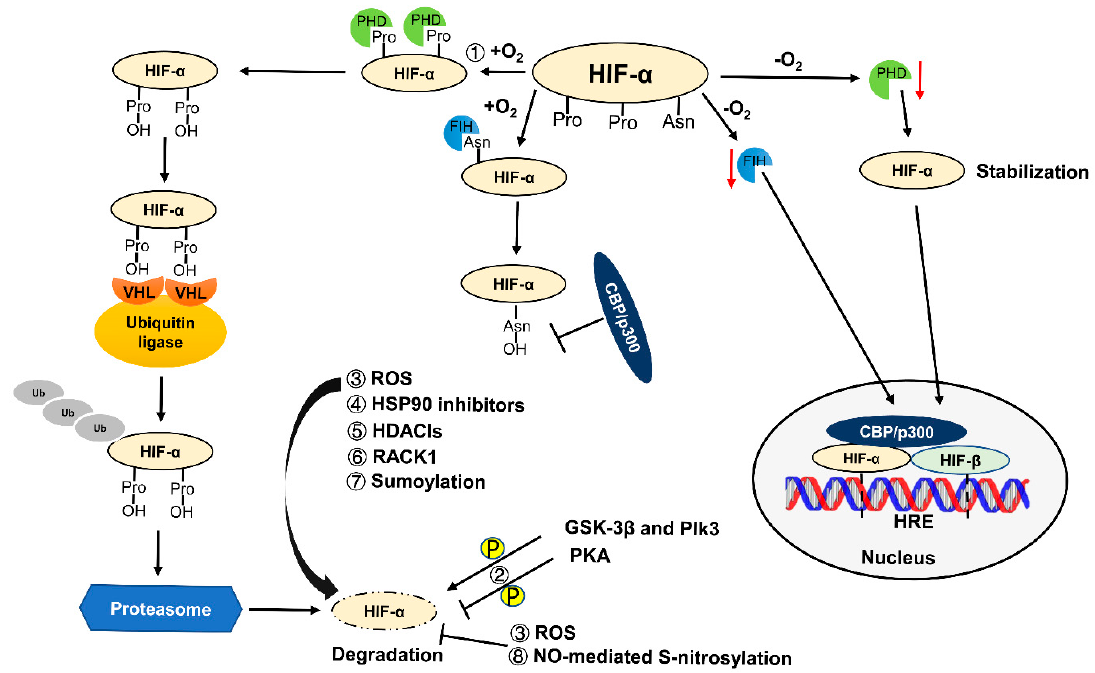
Figure 1. Regulation of the stability and transcription activity of HIF. In the presence of oxygen or normoxia, PHDs hydroxylate two prolyl residues of HIF- α . The hydroxylated HIF- α then binds to VHL-E3-ubiquitin ligase complex, leading to poly-ubiquitination and proteosomal degradation. Meanwhile, FIH hydroxylates an asparaginyl residue of HIF- α . Asparaginyl hydroxylated HIF- α prevents the recruitment of CBP/p300 coactivators, which is required for the full transcriptional activity of HIF. In the absence of O 2 or hypoxia, PHD-mediated prolyl residue hydroxylation is inhibited, resulting in HIF- α stabilization. The stabilized HIF- α translocates into nucleus and then dimerizes with HIF- β to transactivate target genes. Meanwhile, FIH-mediated asparaginyl residue hydroxylation is also inhibited, causing the recruitment of CBP/p300 coactivators to enhance the transcription activity of HIF. In addition to oxygen, phosphorylation and ROS may play dual roles in HIF- α regulation; HSP90 inhibitors, HDACIs, RACK1, and sumoylation can decrease the stability of HIF- α , while NO-mediated S-nitrosylation can enhance the stability of HIF- α . Abbreviations: hypoxia-inducible factor (HIF), prolyl hydroxylase domain-containing protein (PHD), von Hippel–Lindau (VHL), factor inhibiting HIF (FIH), CREB-binding protein (CBP), hypoxia response element (HRE), reactive oxygen species (ROS), histone deacetylase inhibitors (HDACIs), receptor of activated protein kinase C 1 (RACK1), phosphorylation (P), glycogen synthase kinase-3beta (GSK-3 β ), polo-like kinase 3 (Plk3), protein kinase A (PKA), and nitric oxide (NO).